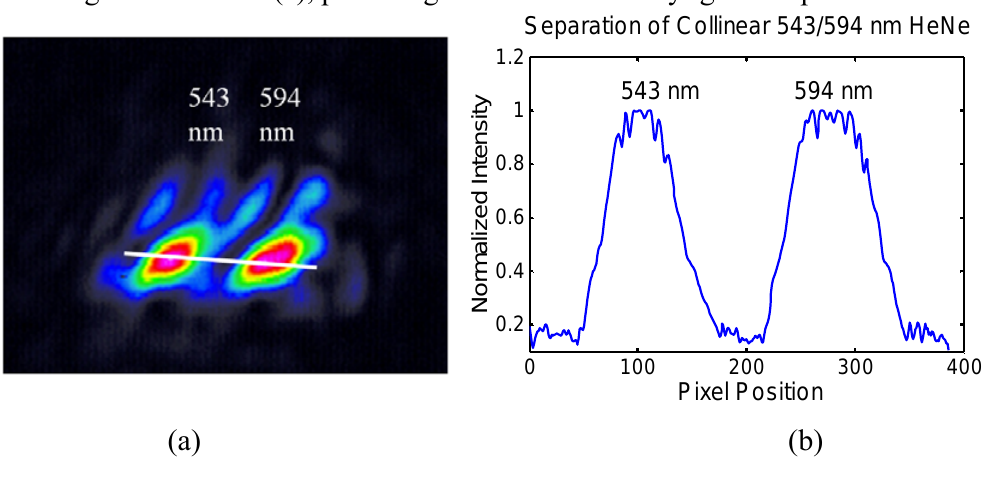
Figure 8. (a) Separation of collinear laser sources at 543 nm and 594 nm. (b) The intensity profile along line drawn in (a), providing resolution and straylight